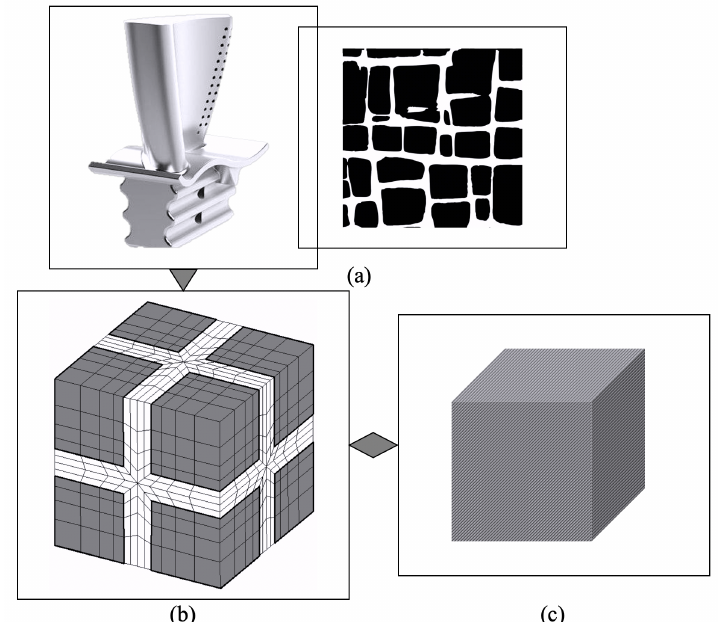
Figure 1. Multi-scale framework of single-crystal nickel-based superalloys: ( a ) Turbine blades with single-crystalline microstructure and cubic precipitates. ( b ) Discretized finite element mesh of a two-phase single-crystal description. ( c ) Homogenized finite element